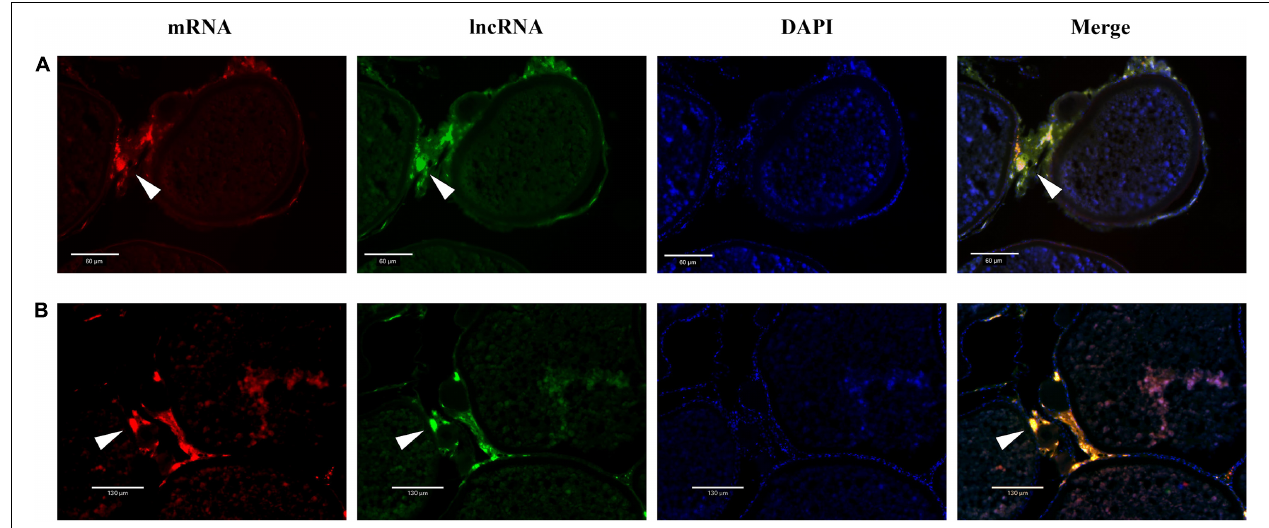
FIGURE 8 | The colocalization of lncRNA and mRNA. (A) The colocalization of cyp17a1 (red, stained with Alexa Fluor 594) and XR_522278.2 (green, stained with Alexa Fluor 488). (B) The colocalization of cyp19a1 (red, stained with Alexa Fluor 594) and XR_522171.2 (green, stained with Alexa Fluor